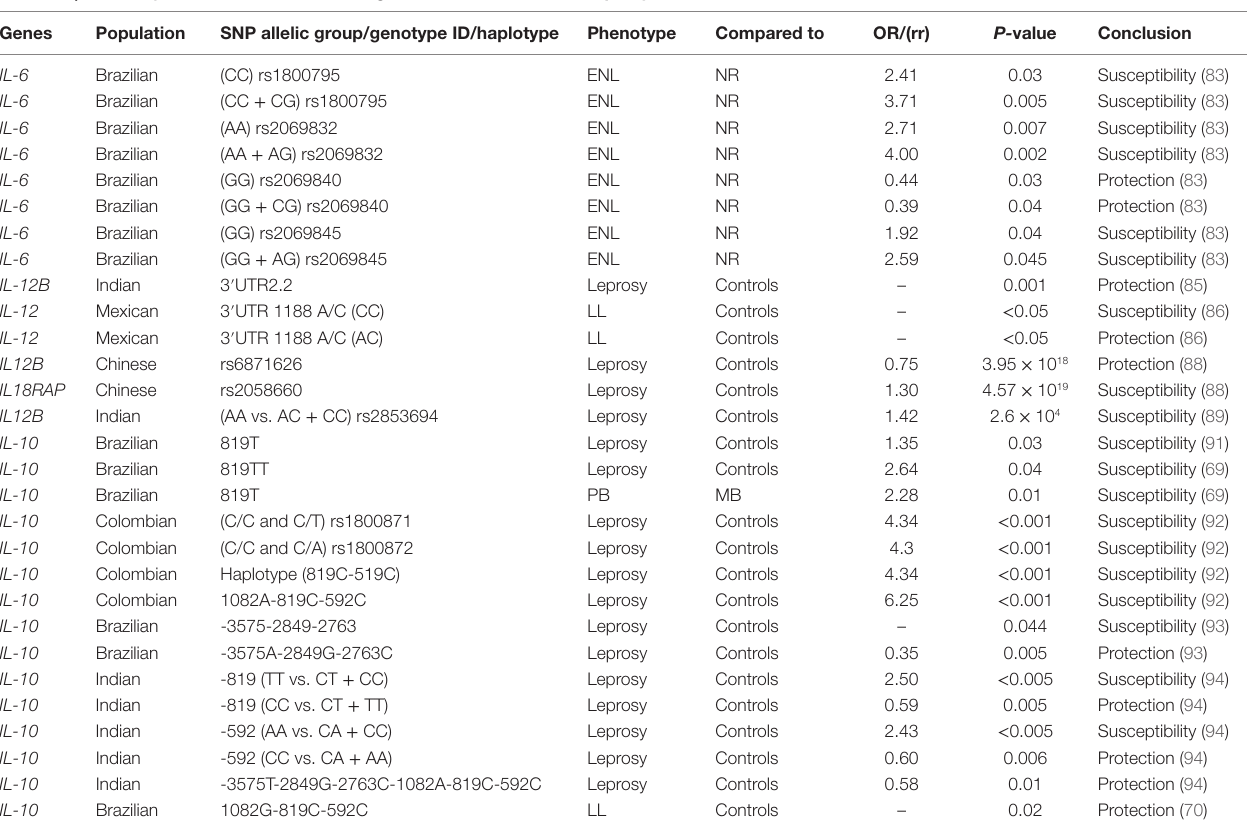
TABLe 4 | Summary of associations between genes of interleukins and